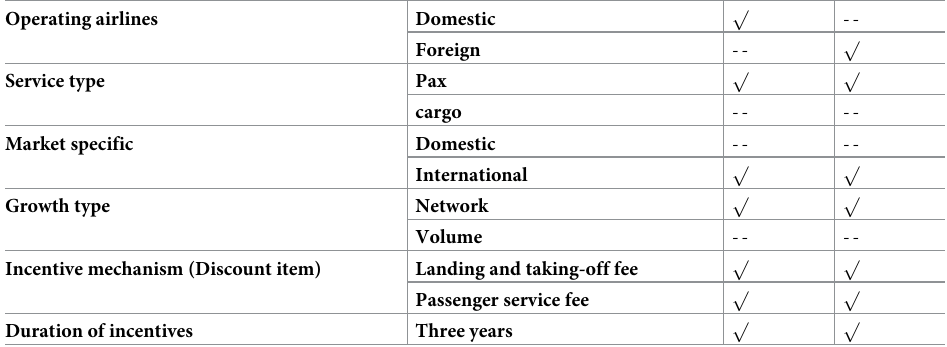
Table 1. Assumptions for international route development analysis in the HGH case